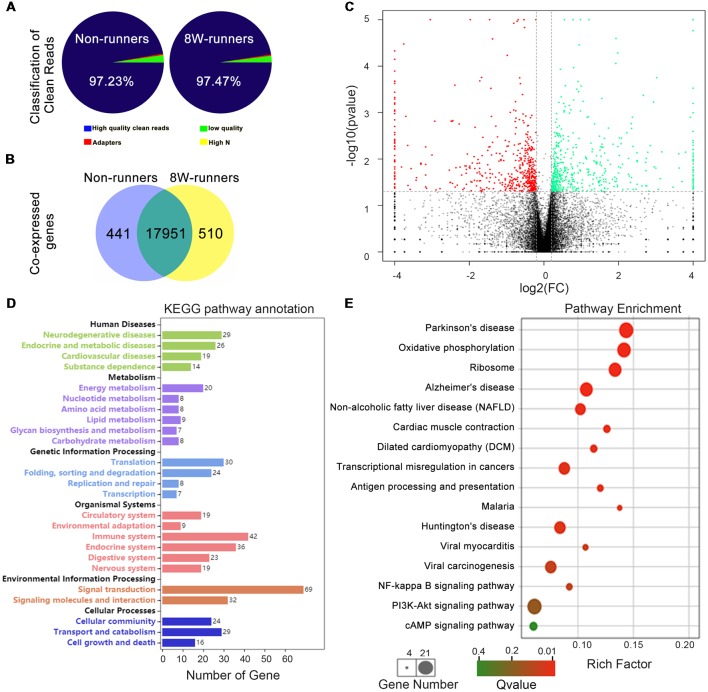
Transcriptomic profiling of mutant mice after training. (A) Classification of clean reads in non-runner and 8-week (8W) runner mutants. (B) There are a total number of 17,951 co-expressed genes in runner and non-runner mutants, 441 unique genes in non-runners, and 510 unique genes in runners. (C) Scatter plots show co-expressed genes in runner and non-runner mutants. Green dots indicate down-regulated genes, and red dots represent up-regulated genes in the runner group, whereas brown dots show genes with no significant changes. Cutoffs of a fold change (FC) at 1.15, and P-value at less than 0.05 are considered significant. (D) Differentially expressed genes (DEGs) annotated in KEEG pathways. (E) KEGG pathway enrichment of the DEGs. The rich factor is calculated using the number of enriched genes divided by the number of all background genes in the corresponding pathway.